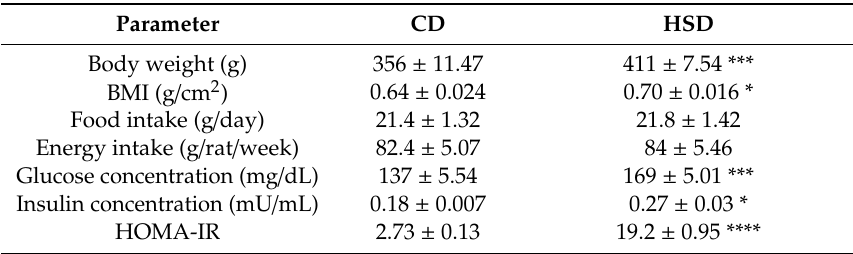
Table 1. General characteristics of the control and high-sugar diet (HSD)-fed